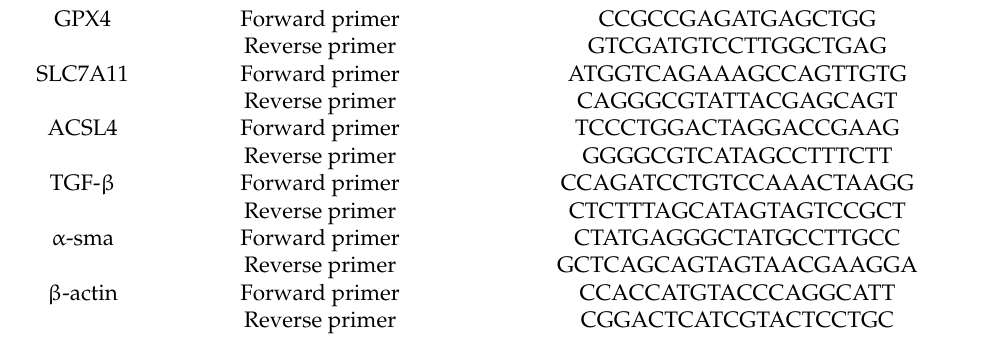
Table 2. Gene primer sequence used for